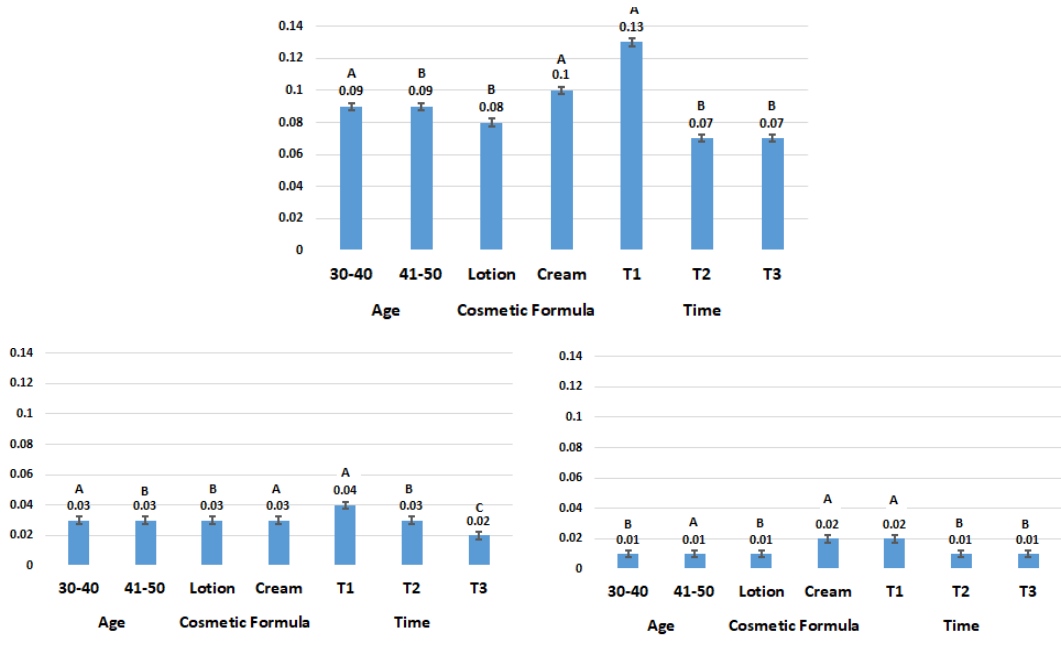
Figure 3. Adjusted means of factors R0, F0 and F1. Note. Two treatments without a common letter are statistically significant ( p ≤ 0.05).